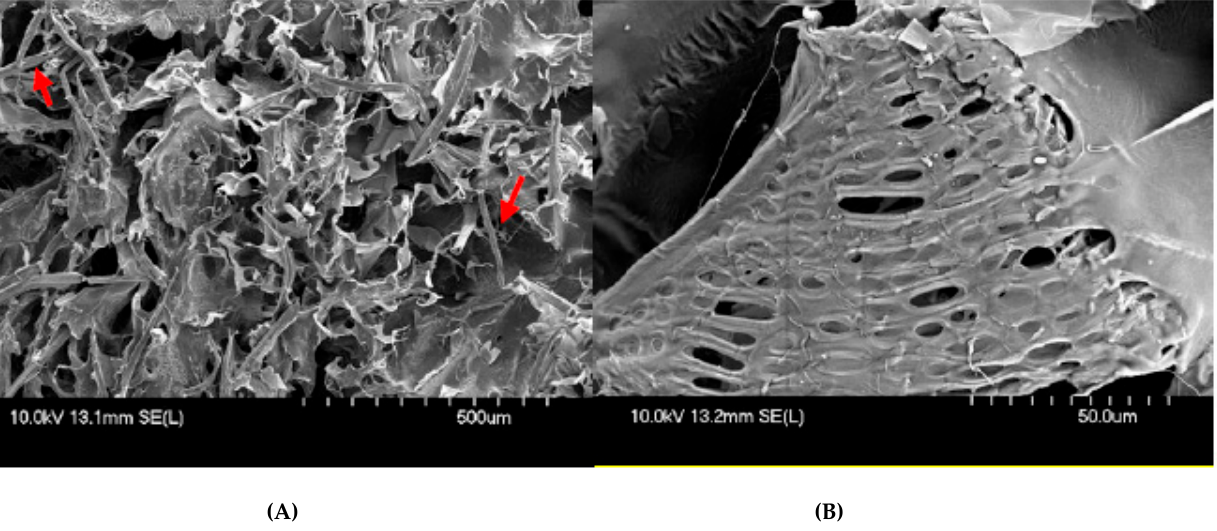
Figure 10. Scanning electron micrographs of freeze-dried F8 [4% CNC: 4% Alg: 40% PEGDA] construct at magnification of ( A ) 100 × and ( B ) 801 × . CNC fibres indicated with arrows.